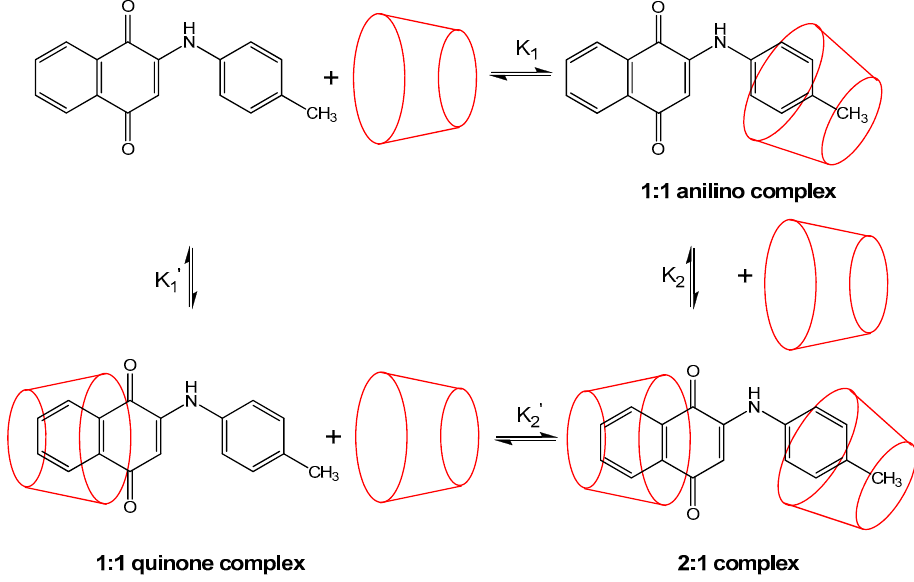
Figure 3. Illustration of the full proposed mechanism for the reversible stepwise formation of the 1:1 and 2:1 host:guest inclusion complexes between β -CD and 2-[( p -methyl-phenyl)amine]-1,4- naphthalenedione (PAN derivative 10) observed in the ESI-MS spectrum shown in Figure 2.